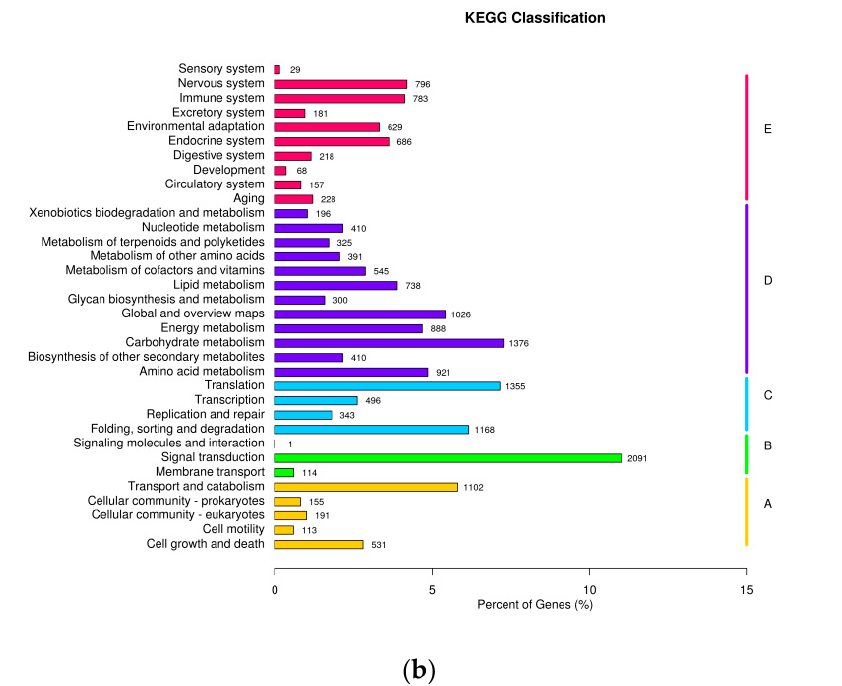
Figure 3. Gene Functional Annotation and Classification. ( a ) GO (Gene Ontology) classification; ( b ) KEGG (Kyoto Encyclopedia of Genes and Genomes) classification.